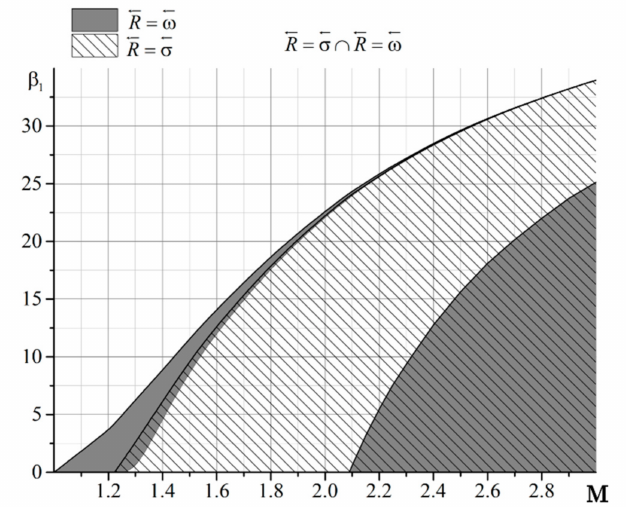
Figure 10. Domains of existence of different types of reflected discontinuity depending on Mach number M and the flow turn angle at the first shock, β 1 , γ = 1.4.